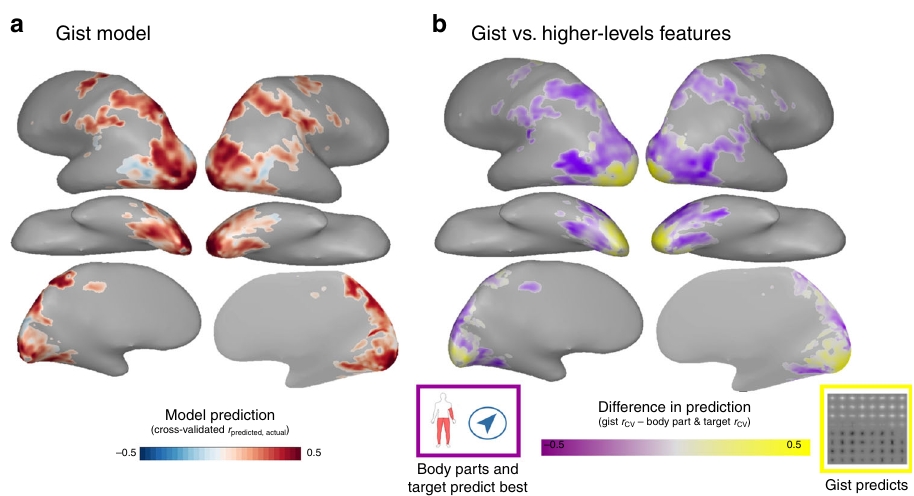
Fig. 5 Incorporating low-level visual features. a Voxel-wise encoding model prediction results for the gGist model in reliable voxels. Voxel color re fl ects the cross-validated correlation between predicted and actual response patterns to held-out items. b Two-way preference map comparing prediction performance for the gist features with performance for the body parts and action target features. Voxels are colored according to the model with the best cross-validated prediction performance: yellow for gist, and purple for the body parts and action target features. Color saturation re fl ects the strength of the voxel ’ s preference ( r CV for the gist model — r CV for the body parts and action target model). Icons used to depict body part and target features were custom-made or based on images purchased from the Noun Project (Creative Commons License CC BY 3.0, https://creativecommons.org/licenses/by/ 3.0/), which were then colored and arranged by the authors. All brain fi gures were created by the authors.